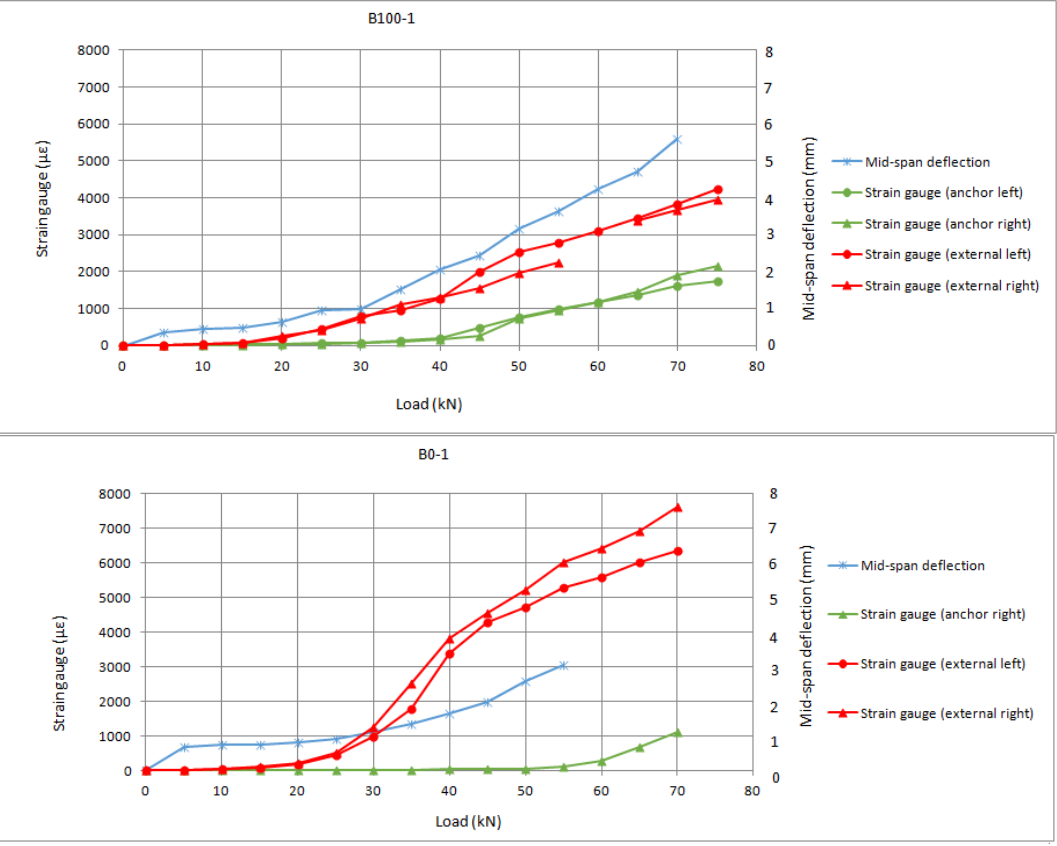
Figure 8. Load-slip response of the B series.